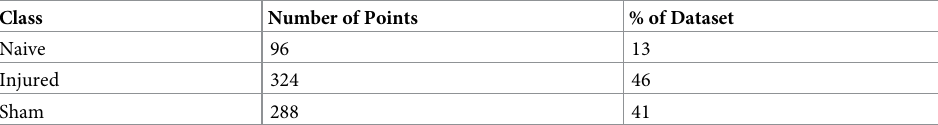
Table 1. Outline of class distribution in the